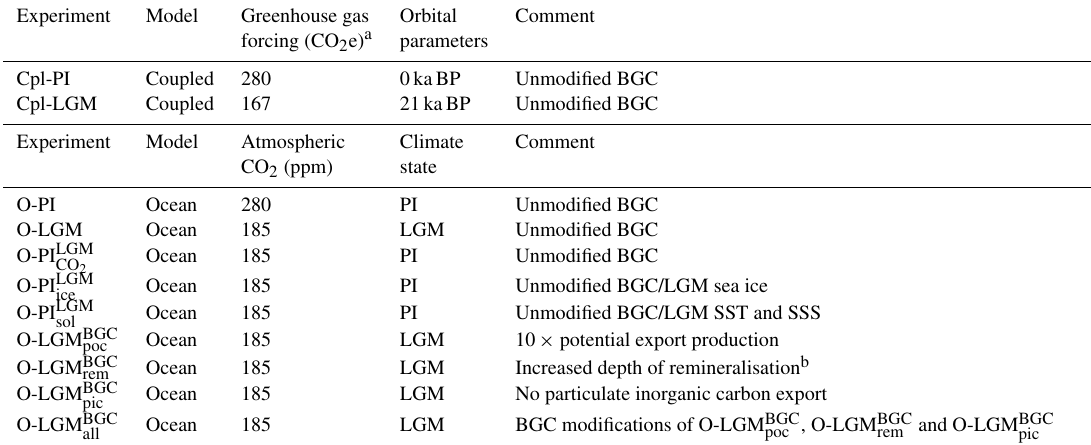
Table 1. Summary of modelling experiments performed. An O before a model name denotes that it was an ocean-only simulation. BGC refers to